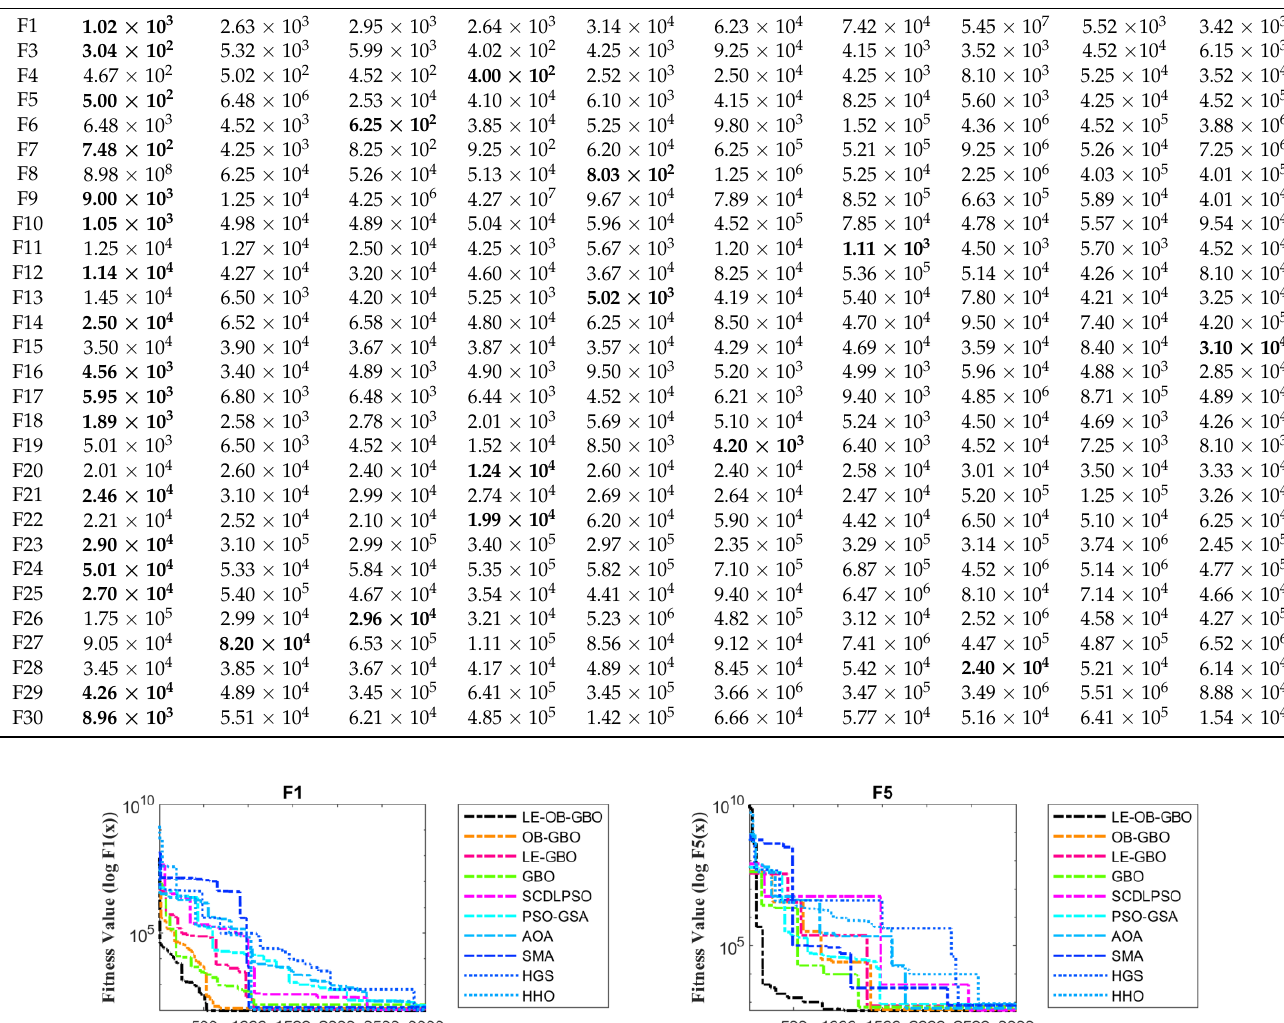
Table 3. Statistical comparison of the mean values of the CEC—2017 benchmark evaluation (D = 30).